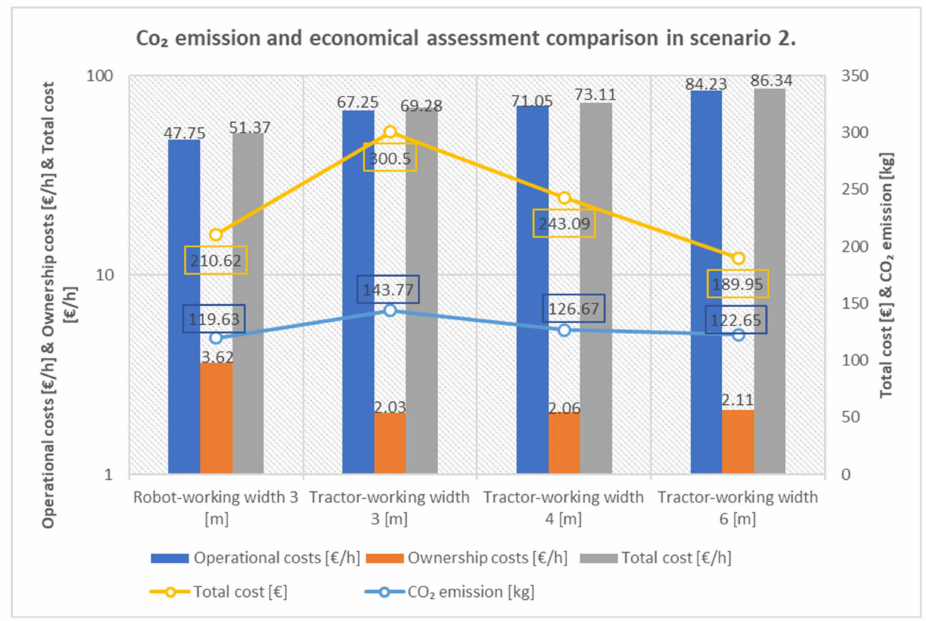
Figure 16. The comparison of economical assessment and CO 2 emission between robot and tractor in the second